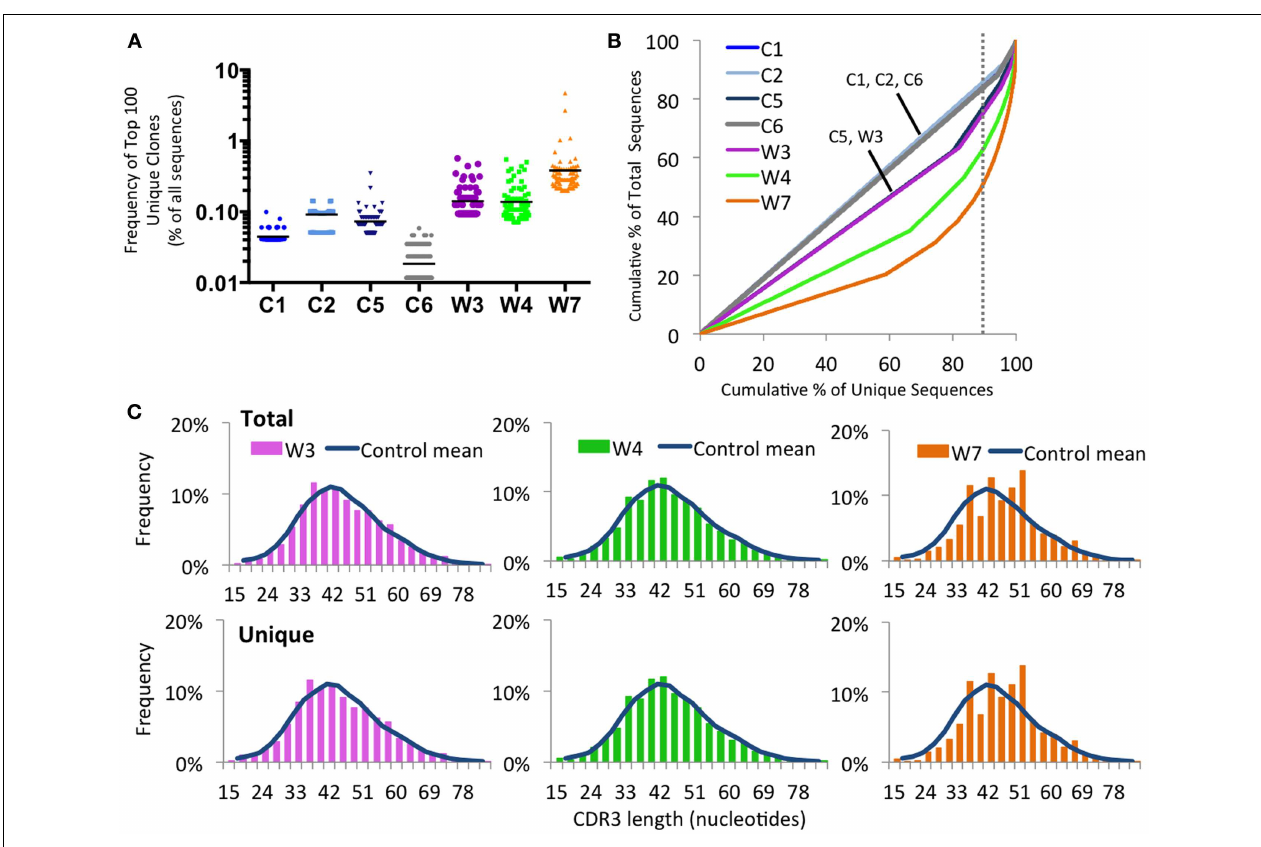
of total sequences ( y ). A slope of one would indicate an even distribution of clonotypes.The dotted gray vertical line indicates 90% of cumulative unique sequences, with sequences to the right of the line corresponding to the top 10% most abundant clonotypes. (C) Distribution of CDR3 nucleotide length frequencies for both total and unique sequences in individualWAS patients compared to the mean in controls C1 and C2 (shown as a curve).